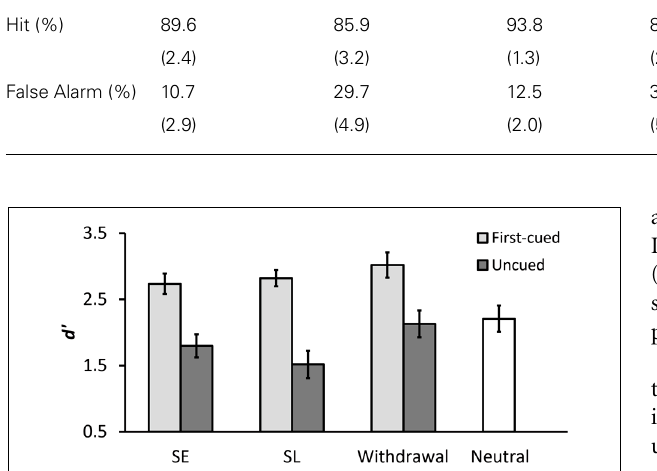
FIGURE 3 | Mean d (cid:2) for each cue type condition in Experiment 1. Error bars represent standard errors.